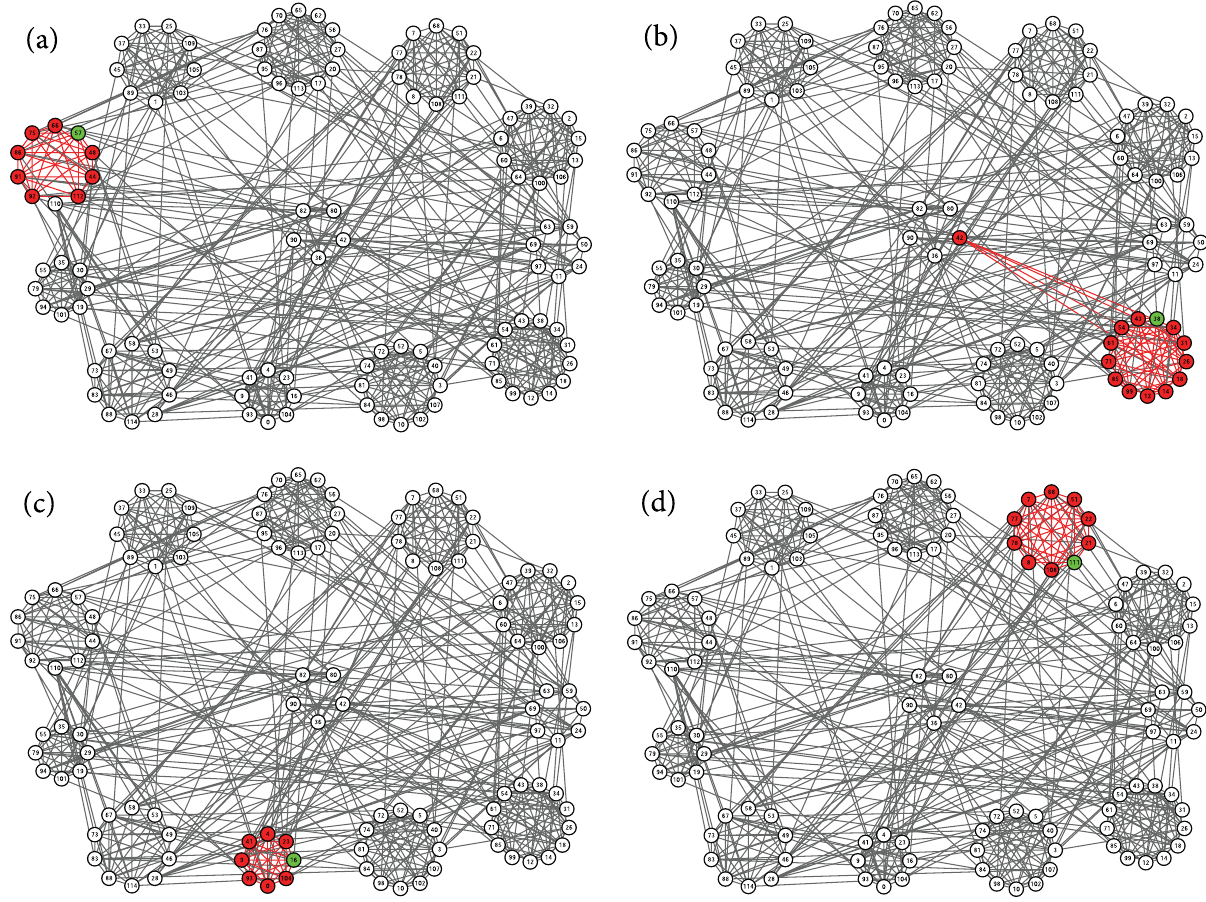
Figure 6. Identified local communities (red) of college football teams. Circles of nodes indicate the conferences of football teams. The five nodes placed in the middle represent five independent teams. Each of the subfigures shows the local clustering result generated by the proposed method, using seed nodes (green) 57, 38, 16, and